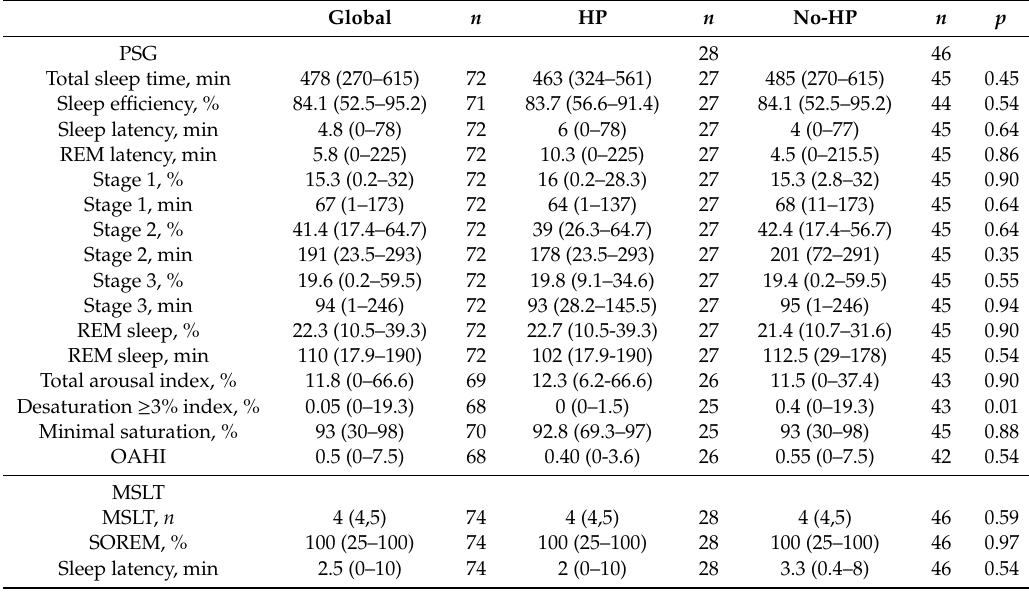
Table 3. Sleep and respiratory characteristics of children with and without